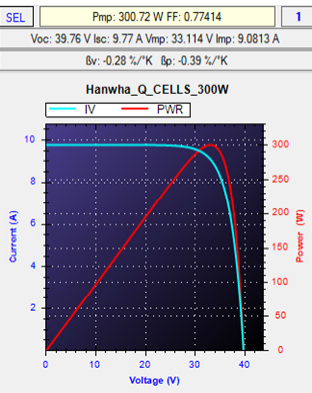
Figure 12. ( a ) Photograph and ( b ) block diagram of the equipment settings for experiments to evaluate the MPPT performance.